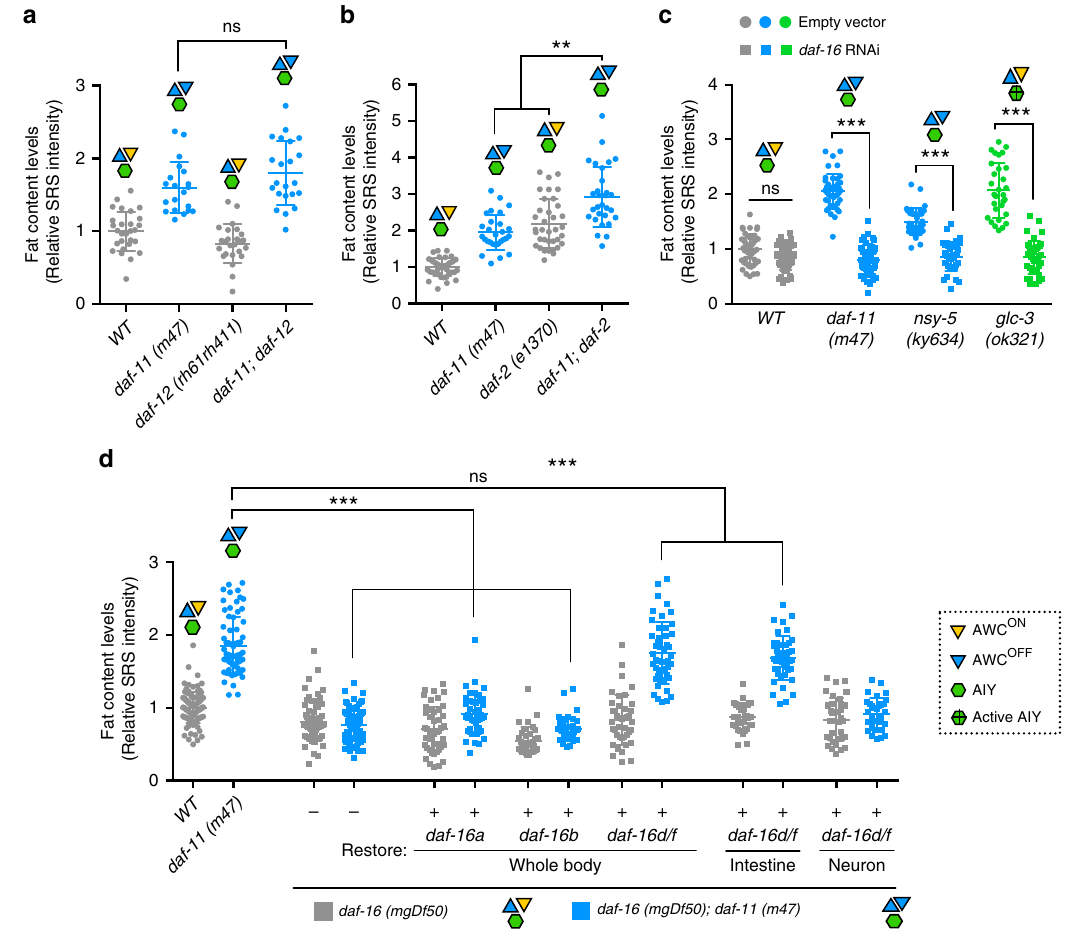
Fig. 4 Speci fi c FOXO isoforms mediate the olfactory regulation of fat metabolism. a Inactivation of the nuclear hormone receptor DAF-12 does not suppress the increased fat storage in the daf-11 mutants with only AWC OFF neurons. Representative SRS images are in Supplementary Fig. 6i. b The daf-2 mutation leads to fat storage increase, and further enhances the fat storage increase in the daf-11 mutants. Representative SRS images are in Supplementary Fig. 6j. c DAF-16 is required for the increased fat storage in the daf-11 and nsy-5 mutants, that lack AWC ON neurons, and in the glc-3 mutants with activated AIY neurons. Representative SRS images are in Supplementary Fig. 7a. d The daf-16 deletion fully suppresses the increased fat storage in the daf-11 mutants, which can be rescued by restoration of the daf-16d/f , but not the daf-16a or daf-16b isoform. Intestine-only but not neuron- only restoration of the daf-16d/f isoform suf fi ciently rescues the fat storage increase in the daf-11; daf-16 double mutants. Representative SRS images are in Supplementary Fig. 7b. For a , b , c data are mean ± s.d., ** P < 0.01, *** P < 0.001, n.s. not signi fi cant by two-way ANOVA with Sidak ’ s multiple comparison test. For d , data are mean ± s.d., *** P < 0.001, n.s. not signi fi cant by one-way ANOVA with Tukey ’ s multiple comparison test. Numbers of animals used are listed in Supplementary Data 1. For a – d source data are provided as a Source Data fi